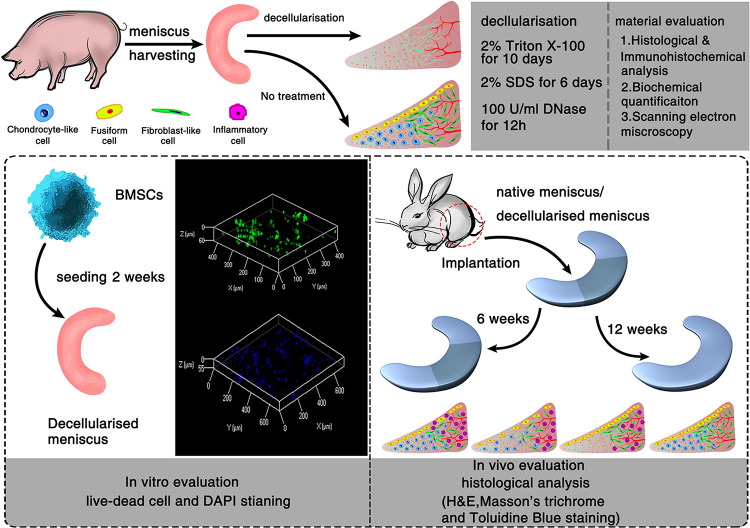
Schematic illustration of the decellularization process of porcine menisci and regeneration of decellularized meniscus. In vitro and in vivo evaluation of meniscus scaffolds with/without decellularization.